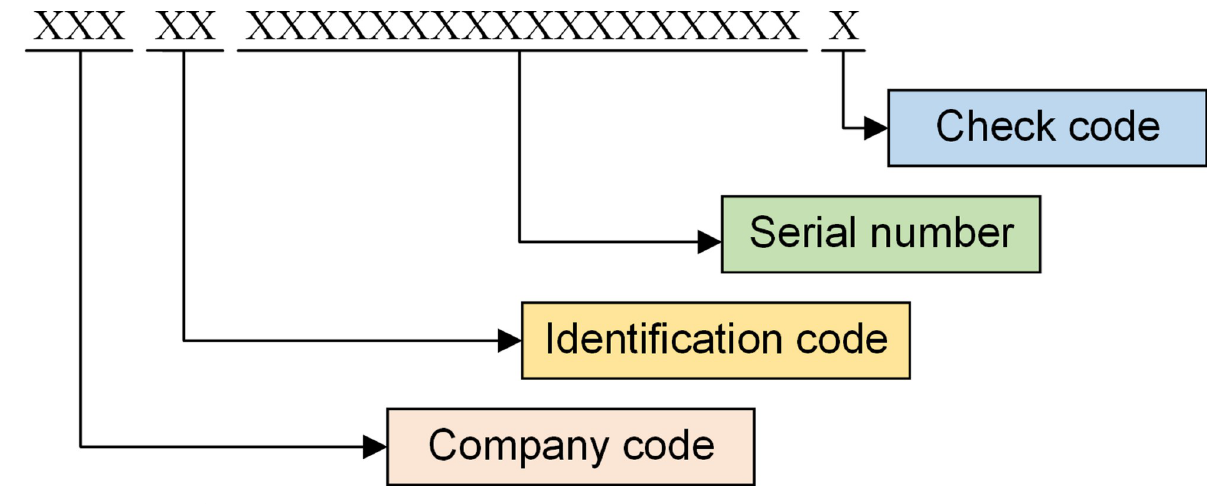
Fig 2. Composition of